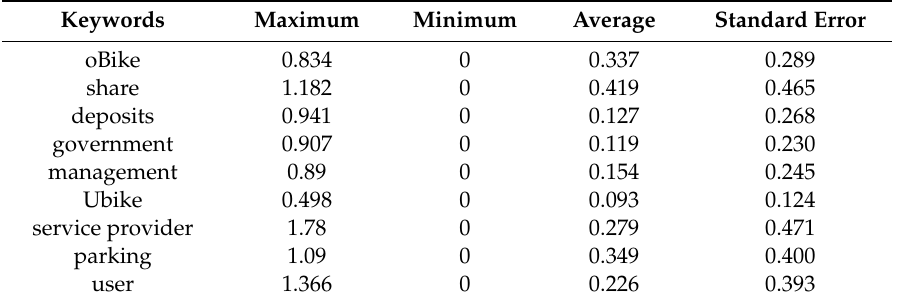
Table 2. Descriptive statistics of major keywords term frequency inverse document (TF-IDF) data.